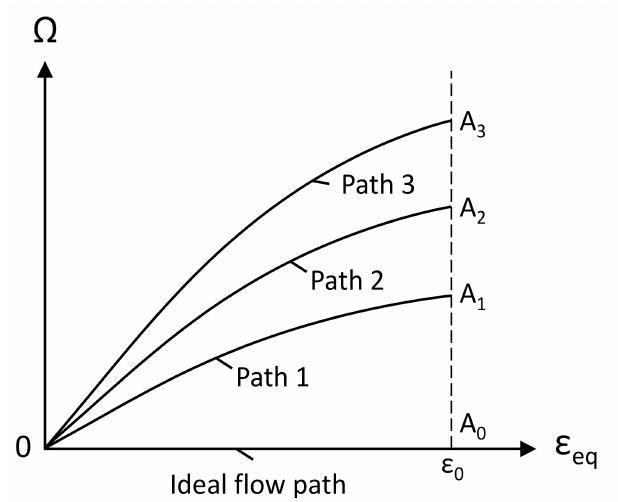
Figure 1. Several paths that result in the same equivalent strain at the end of the process.